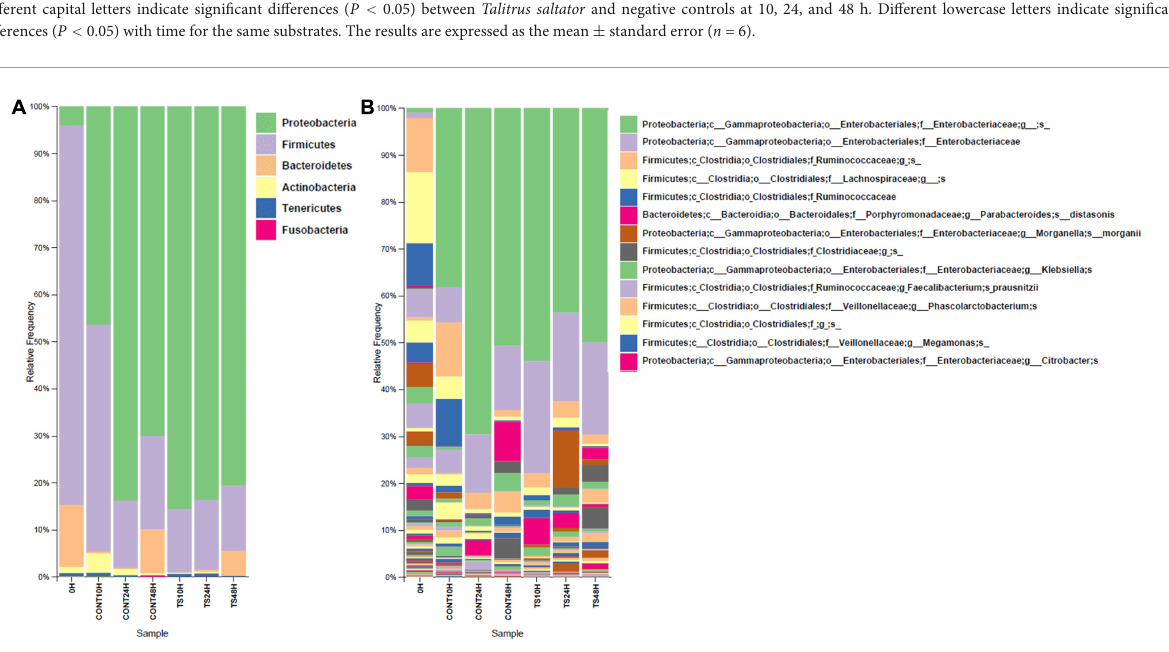
FIGURE1 Relative abundance (%) of operational taxonomic units from different bacterial phyla (A) and genera (B) for group mean values. The X-axis shows different substrates evaluated at different assay times (0, 10, 24, and 48 h). Due to the large number of reported genera, only the top 14 most abundant were placed. These results are the average of the three volunteers on each substrate and at different times. CONT, Negative controls; TS, T. saltator